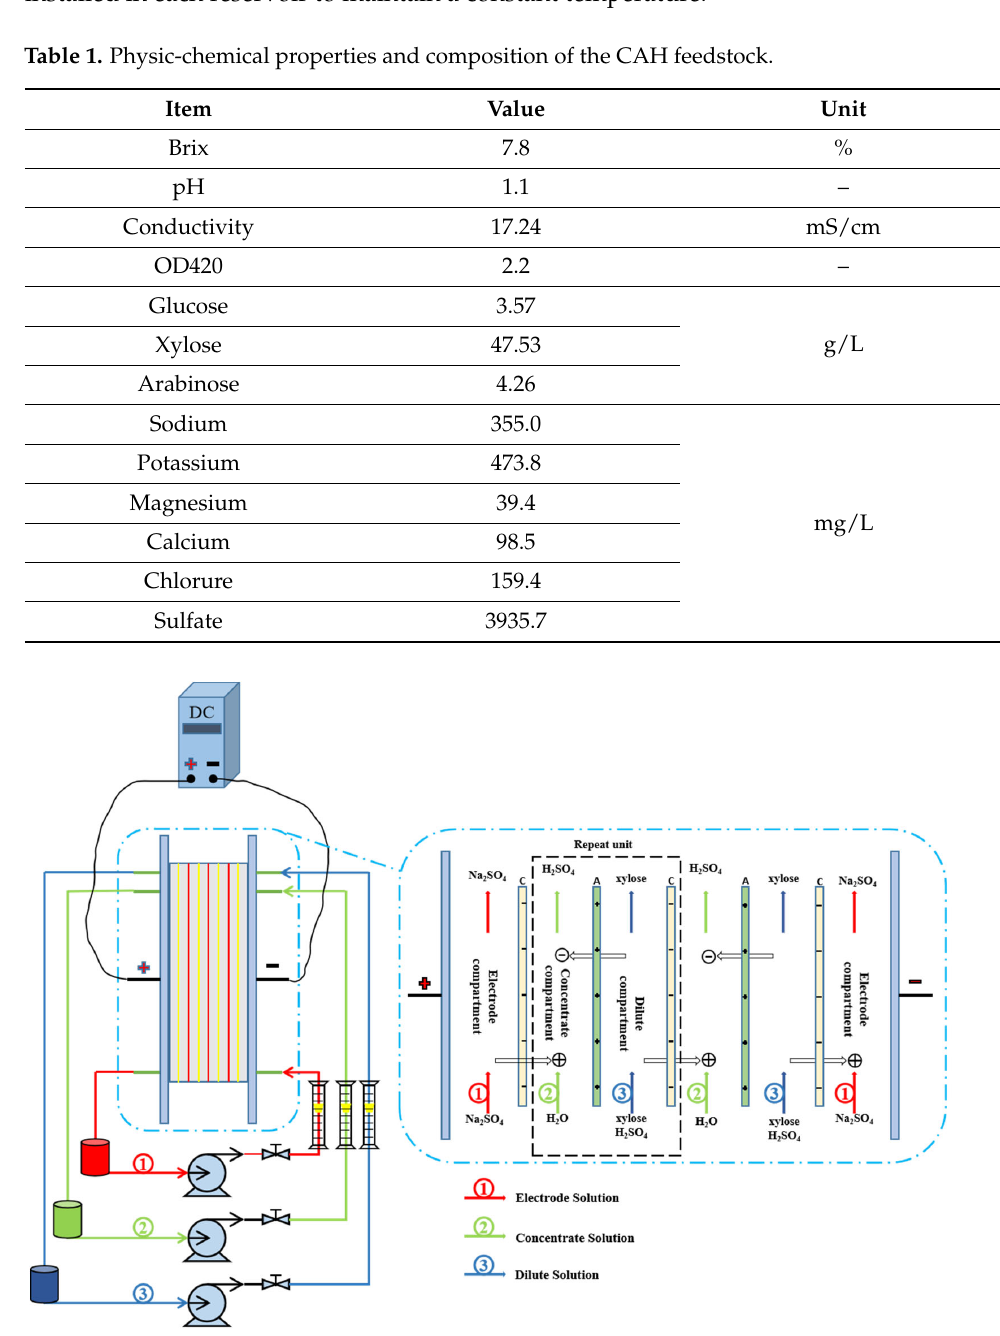
Figure 1. Schematic representation of the ED applied to electrochemical deacidification of CAH. C: CEM, A: AEM. Table 3. Applied operational conditions during electrochemical deacidification method.